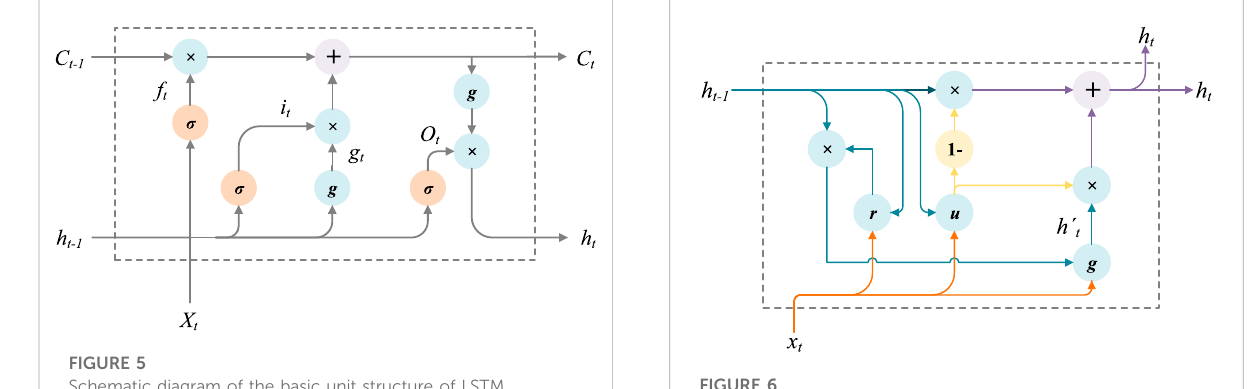
FIGURE 5 Schematic diagram of the basic unit structure of LSTM. FIGURE 6